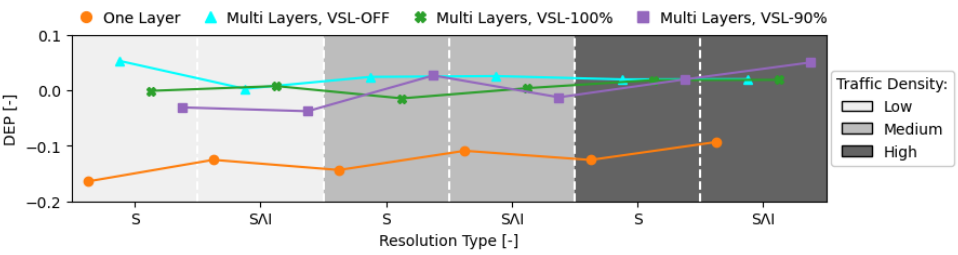
Figure 23. Domino effect parameter